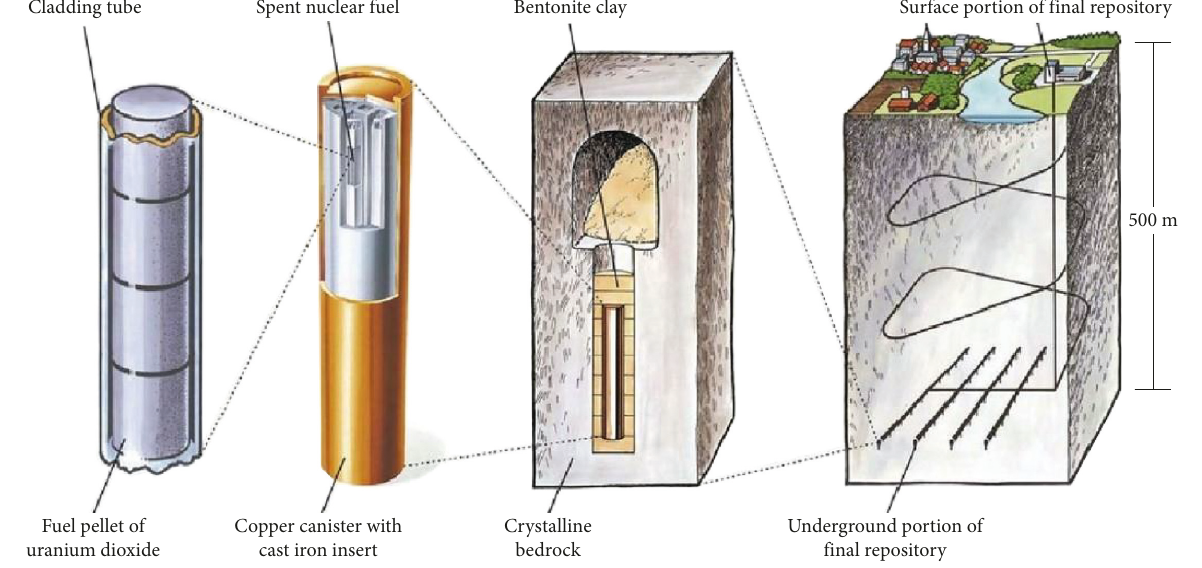
Figure 1: KBS-3 concept of multiple barrier system of SKB in Sweden